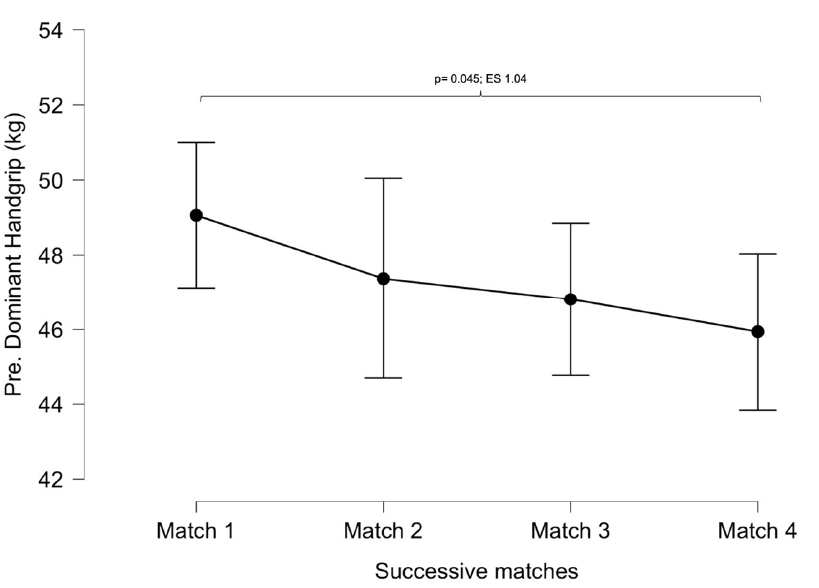
Figure 3. Pre-match dominant handgrip strength throughout successive matches. Lines denote the mean (95 CI).